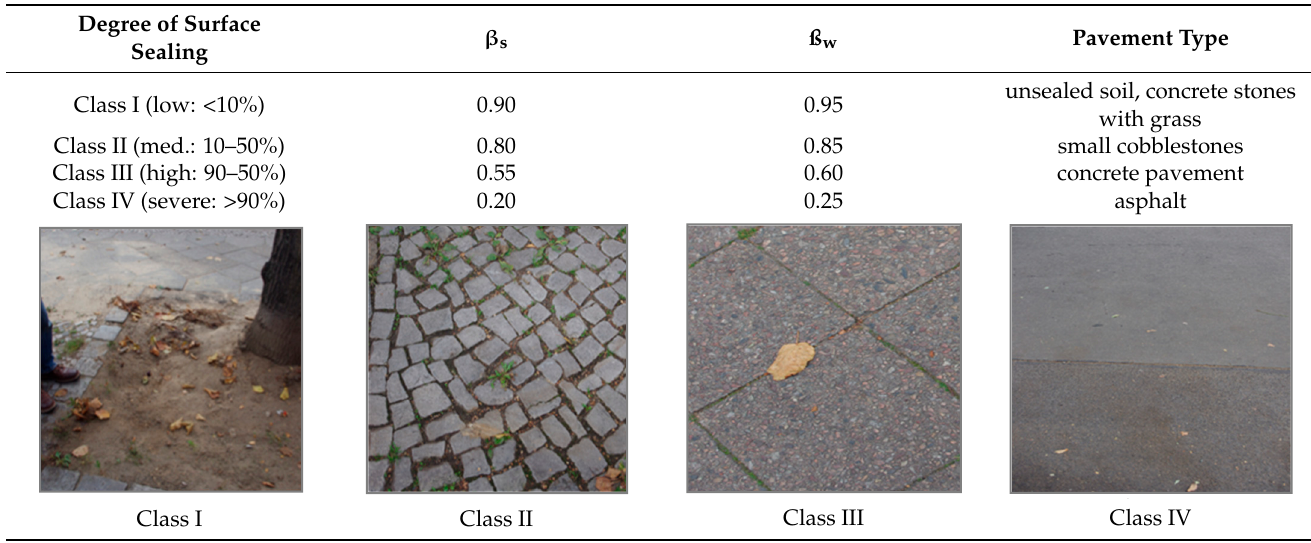
Table 6. ß-coefficients for summer (s) and winter (w) for the different sealing classes (I–IV), with examples according to the site and lysimeter studies of Wessolek et al. [22,53].